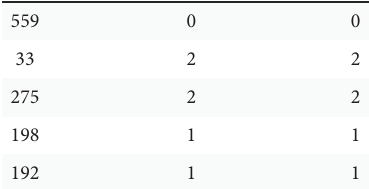
Figure 19: Type classifcation. Table 1 for the dataset used. In addition to prediction